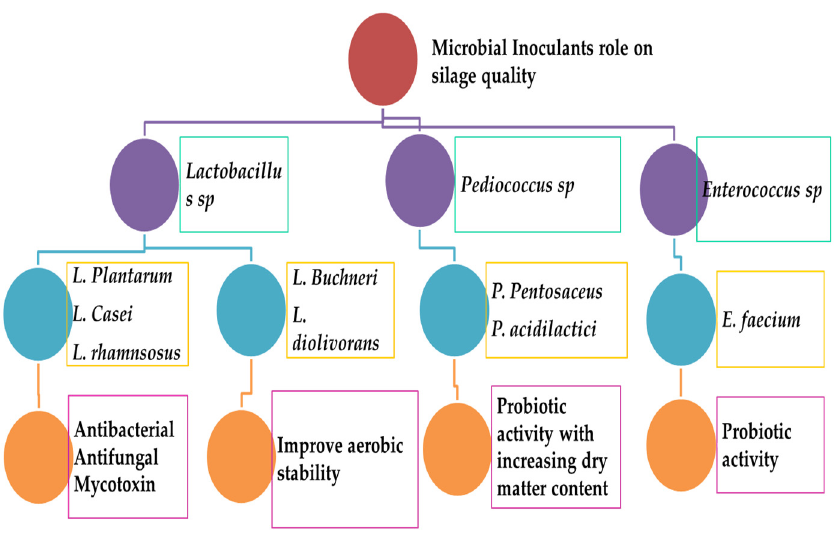
Figure 4. Role of lactic acid bacteria on silage production and preservation.